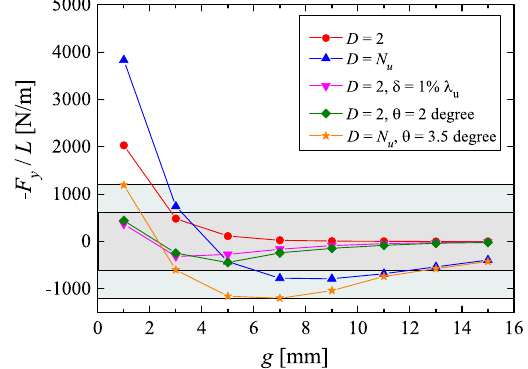
FIG. 8. Numerically calculated magnetic forces for the PCU ( D ¼ 2 ) and the PCU ( D ¼ N ) with and without the fine u adjustments by the additional shift and the easy axis rotation.